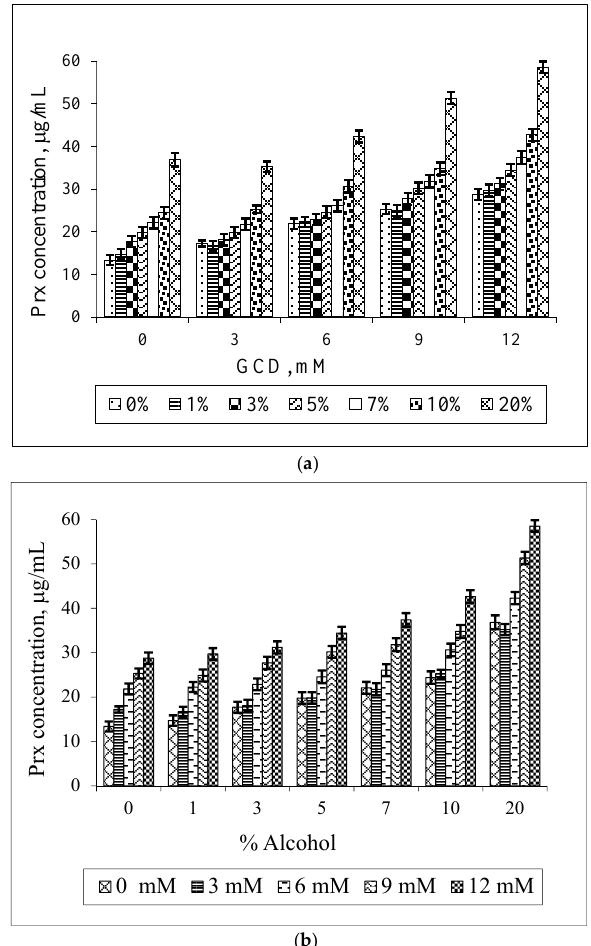
Figure 6. Effect of GCD concentrations on the solubility of Prx in Prx–GCD–ethanol ternary mixtures varying the percentage of ethanol ( a ); effect of ethanol on the solubility of Prx in Prx–GCD–ethanol ternary mixtures varying GCD concentrations ( b ).